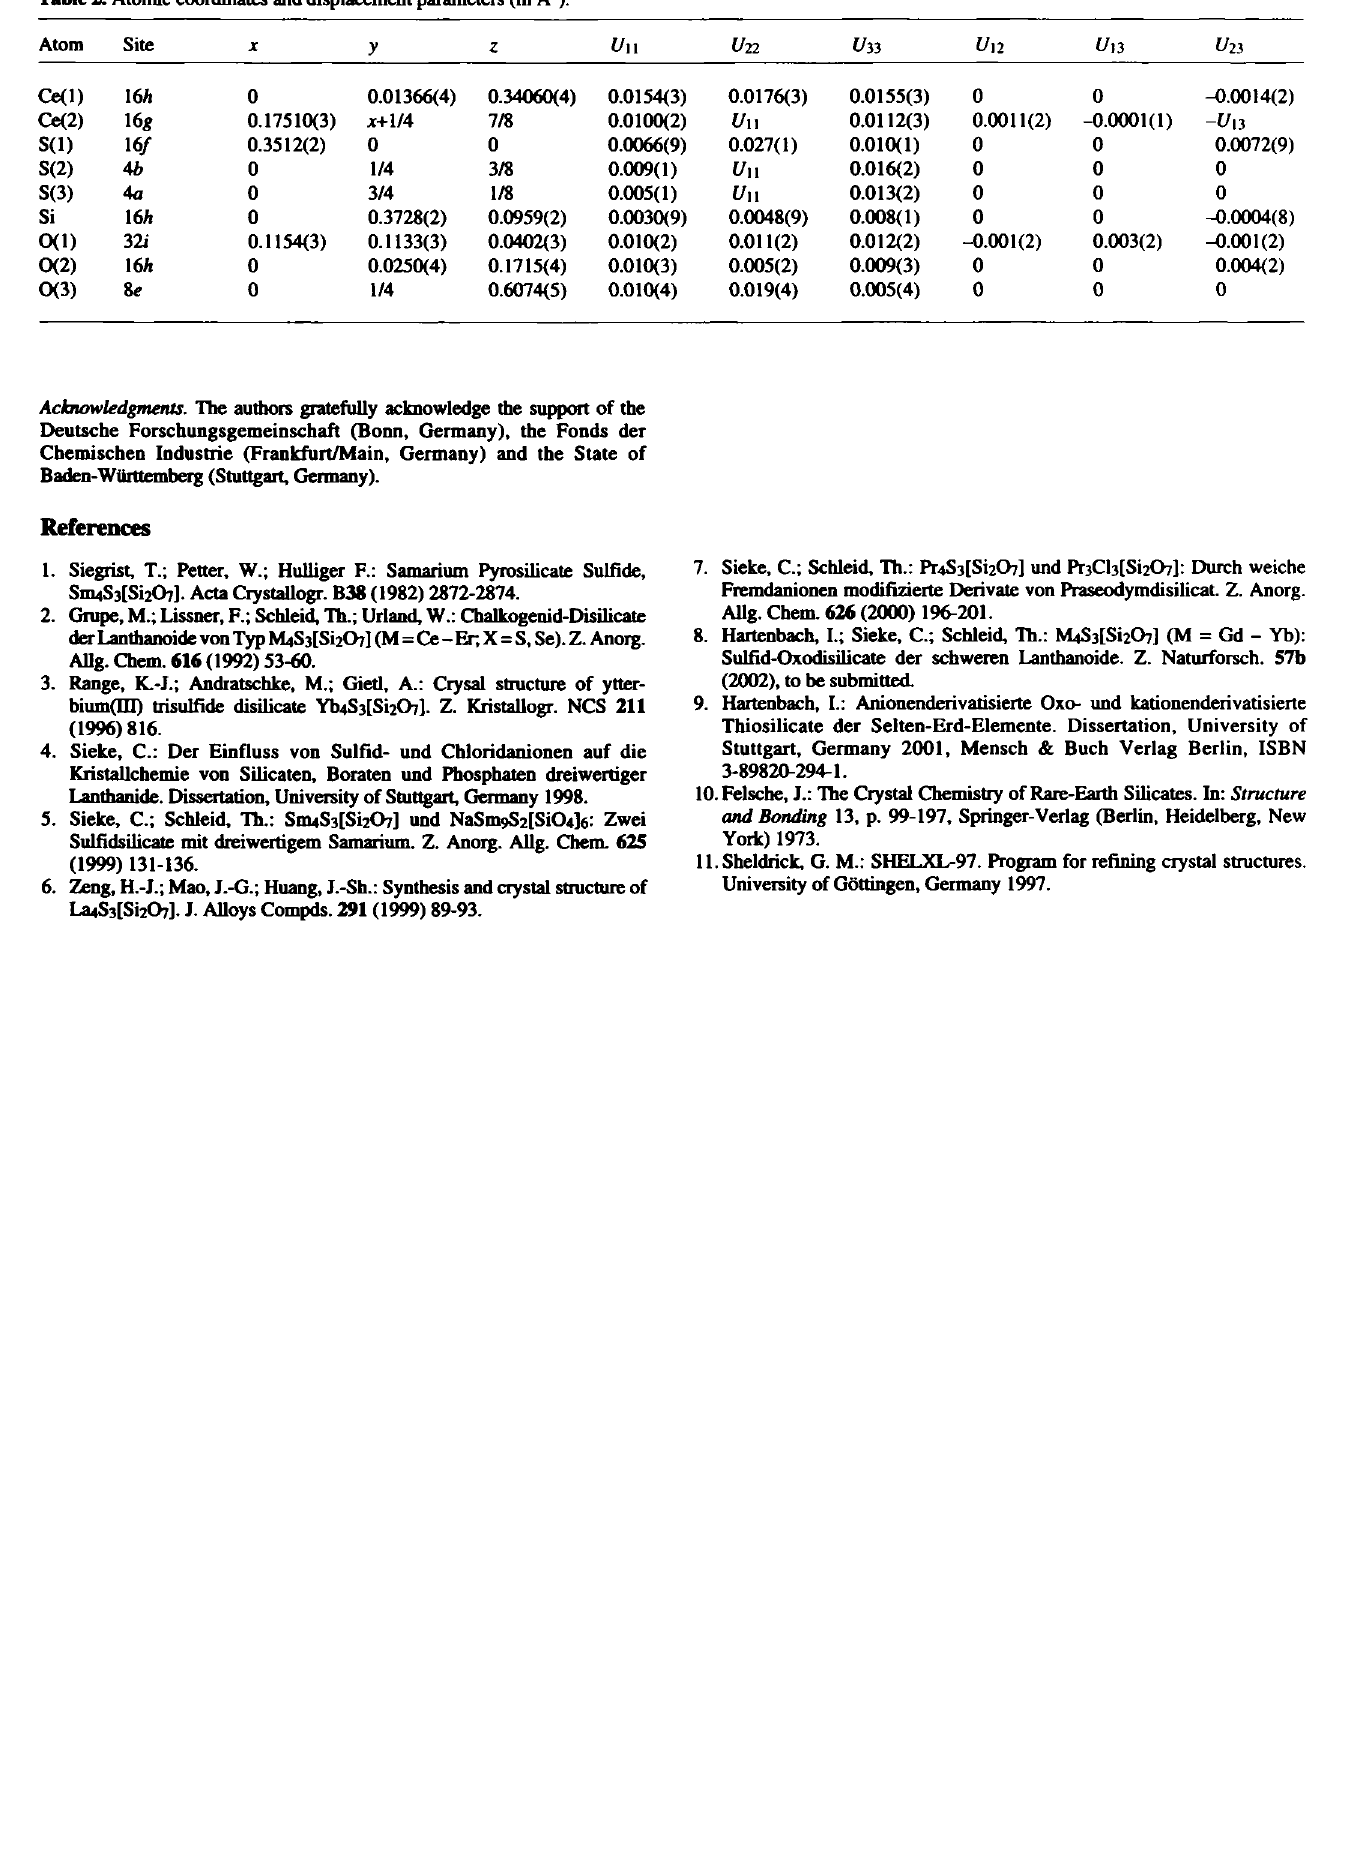
Table 2. Atomic coordinates and displacement parameters (in Â 2